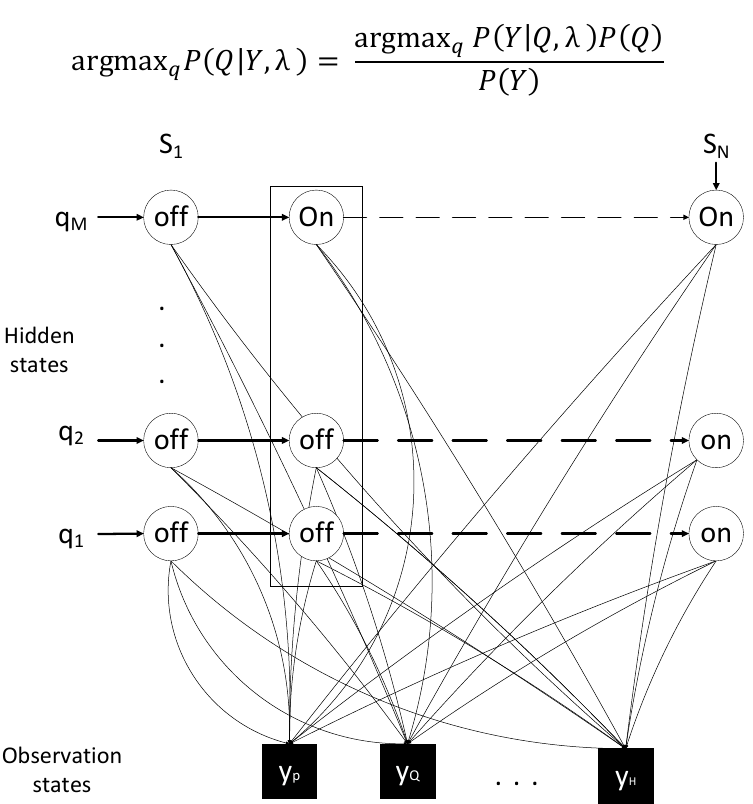
Figure 3. Network topology of multiple conditional factorial hidden Markov model